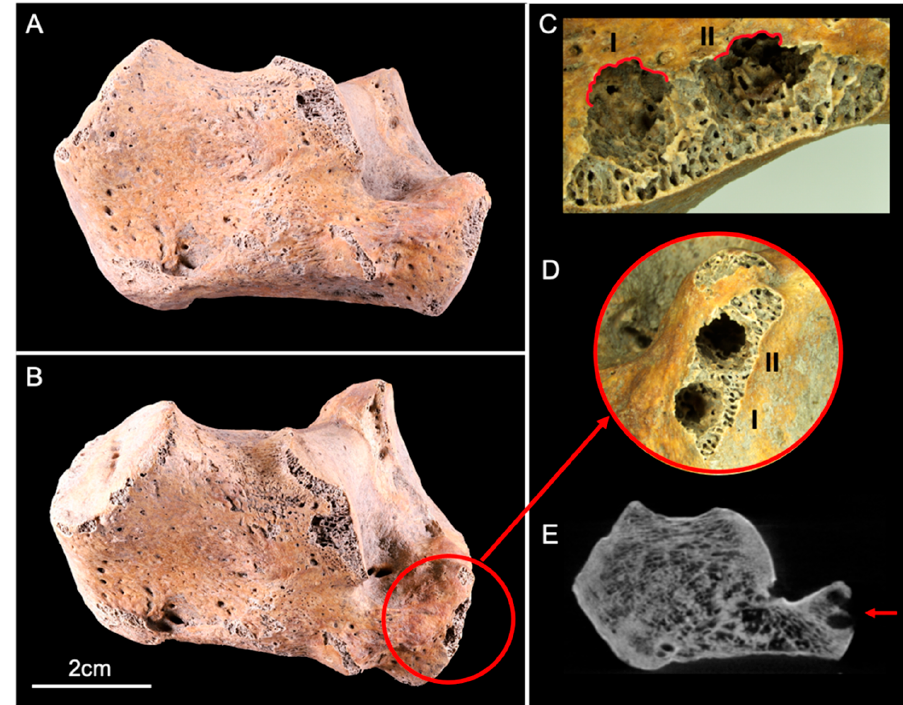
Figure 2. Lateral view of the human calcaneus before ( A ) and after ( B ) the experiment. The red circle ( B , D ) delineates two circular lesions (I and II) located on the anterolateral articular facet, with scalloped margins (( C ), red lines). ( E ) CBCT cross-section shows the two lesions (red arrow) that destroyed the cortical and trabecular bone.